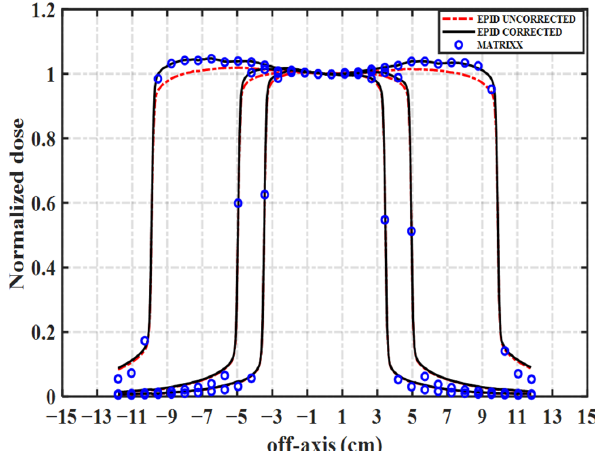
Figure 5. Comparison of uncorrected and corrected EPID images with the measured value of ICA in